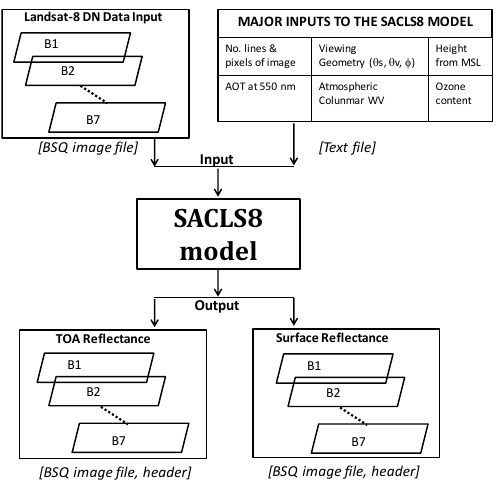
Figure 2: Schematic diagram showing the inputs and flow for the SACLS8 implementation.